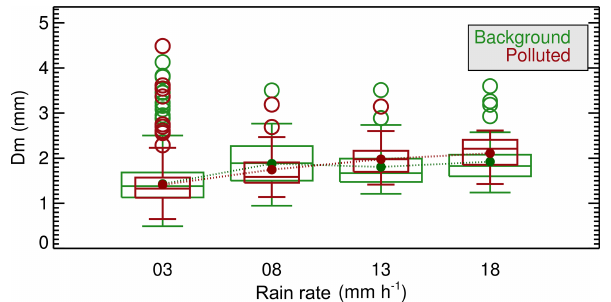
Figure 7. Mass-weighted mean rainfall diameter as a function of the rainfall rate (RR) during the wet season for clean (CPC smaller than the 33rd percentile) and polluted (CPC larger than the 66th per- centile) air over the T3 site. Each box represents the 25 to 75% pop- ulations, and the line inside the box shows the median value; circles represent